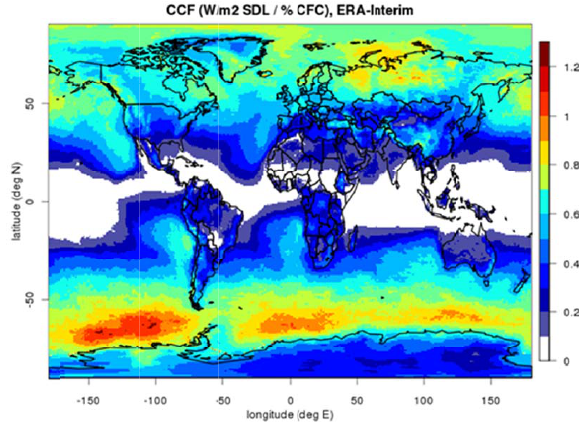
Figure 11. Tempo oral average e of the clooud correcttion factor [W m -2 % -1 1 ] derived f ERA-Int terim data s set. m − 2 % − 1 ] derived from the ERA-Interim